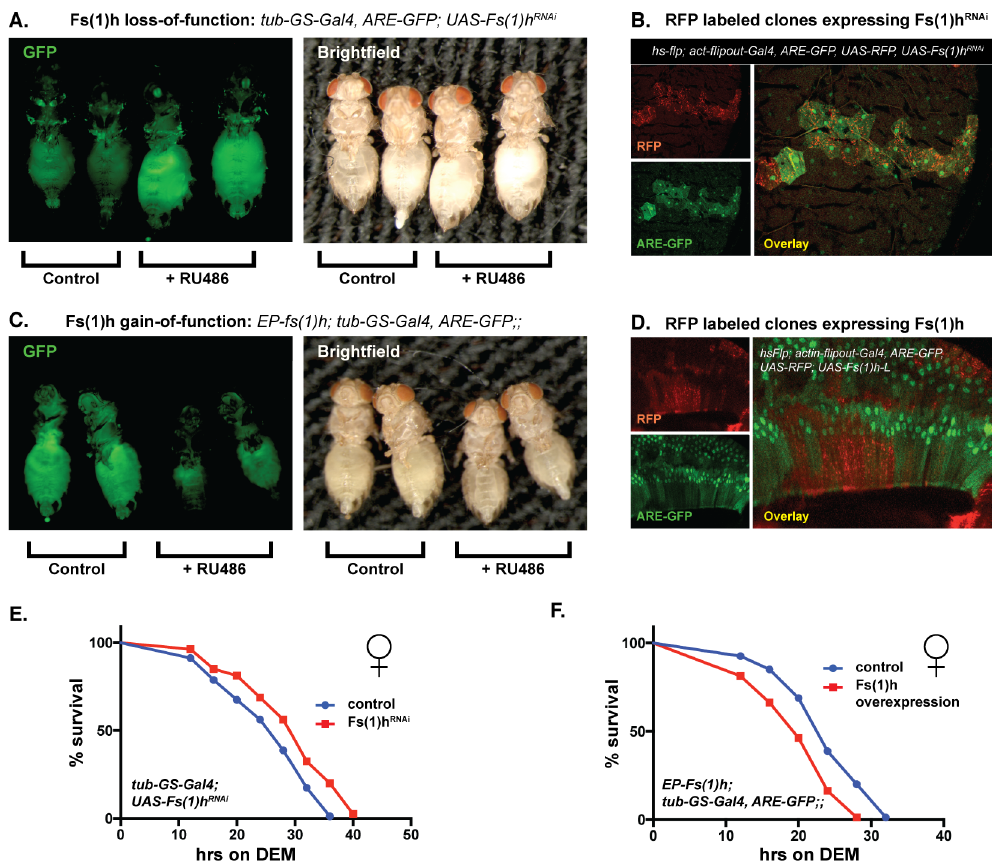
Fig 2. Fs(1)h-L cell-autonomously inhibits CncC activity and affects oxidative stress resistance in adult flies. (A) Ubiquitous knock down of Fs(1)h (in the v51227 RNAi line) in adult flies, using the RU486-inducible tub- GS-Gal4 driver stimulates ARE-GFP reporter activity in most tissues. Two RU486-treated and two mock-treated females are shown in this panel and in panel C. The same flies are shown under UV-illumination to visualize GFP fluorescence and under white light. (B) Knock down of Fs(1)h in actin-flipout-Gal4 clones increased ARE-GFP activity in a cell-autonomous manner in the crop of adult Drosophila gut. In the cells in which Fs(1)h expression is knocked down (marked by the expression of RFP, red) ARE-GFP reporter activity (green) is increased. (C) RU486-induced over-expression of Fs(1)h from the EP-fs(1)h allele reduces oltipraz-stimulated ARE-GFP reporter activity in the whole body. Similar effects are seen after ubiquitous over-expression of Fs(1)h-L from a UAS construct (S2 Fig). (D) Fs(1)h-L over-expression in actin-flipout-Gal4 clones (labeled by RFP, red), cell- autonomously reduces ARE-GFP activity in the ejaculatory bulb of adult males. (E) Ubiquitous Fs(1)h knock-down in adult Drosophila by inducible expression of a UAS-Fs(1)h RNAi transgene under the control of the tub-GS-Gal4 driver increases oxidative stress resistance. Survival after exposure to 20 μ M DEM was recorded and the data were analyzed by Mantel-Cox log-rank test. Female flies incubated on RU486 food, showed significantly increased resistance to DEM (P value < 0.001) compared to those on control food. A similar effect was observed in males (S3 Fig). The standard deviations of percent survival among biological replicates in this and other stress sensitivity assays are shown in S1 Document. (F) Fs(1)h over-expression increases stress sensitivity. Fs(1)h was over- expressed from the EP-fs(1)h allele in female flies by exposing them to food containing 300 μ M RU486 for 4 days. Lethality after exposure to 20 μ M DEM was recorded and analyzed by Mantel-Cox log-rank test. The flies that were kept on RU486 food, showed significantly increased sensitivity to DEM (P value < 0.0001) compared to those on control food. The same experiment was also conducted with males and produced qualitatively the same result (S3